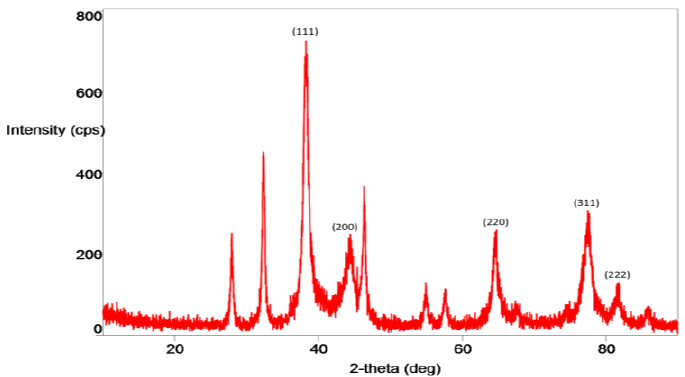
Figure 5. XRD spectrum of the PTAgNPs.